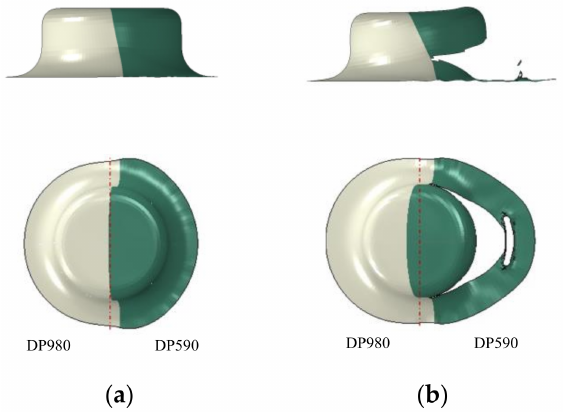
Figure 4. The final shape of drawn blank ( a ) without a bead, ( b ) with fixed bead.